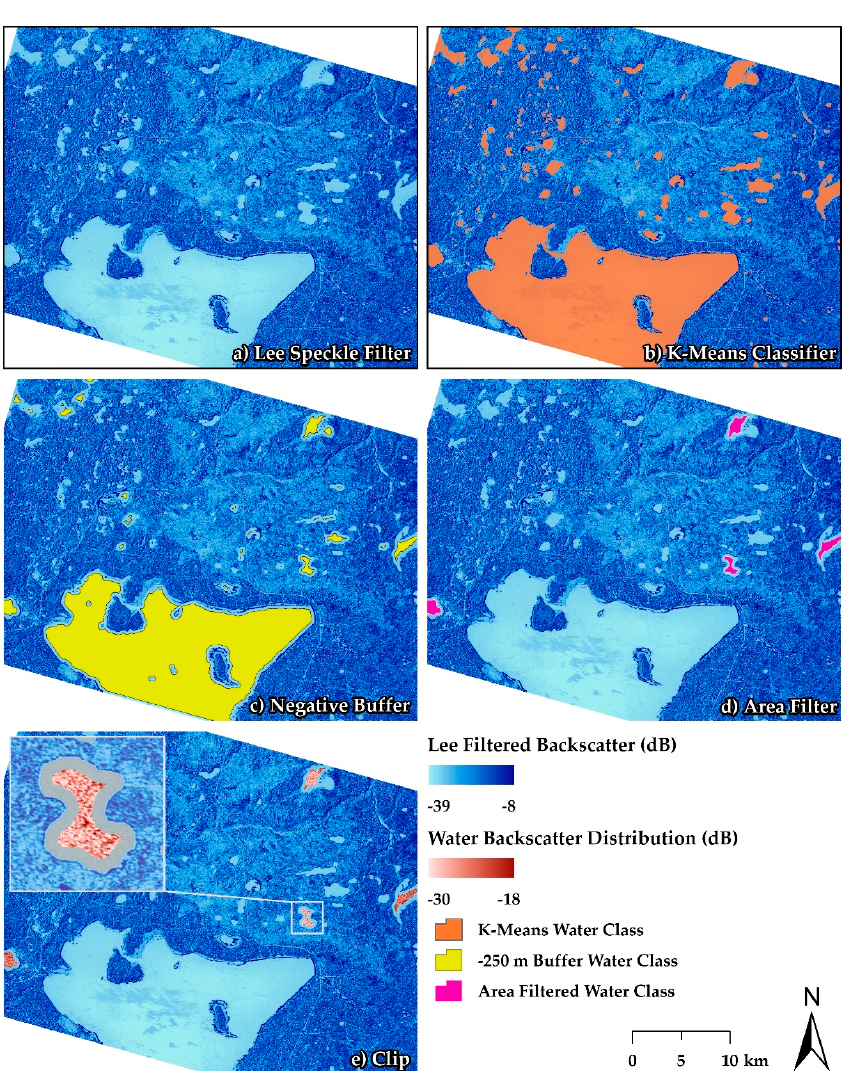
Figure 3. Visualisation of the SAR water mask threshold calibration routine. ( a ) The SAR backscatter image is subject to a Lee speckle filter, followed by ( b ) a 2-class K-Means unsupervised classification. ( c ) A negative buffer ( − 250 m) is applied to remove transitional shoreline influences, ( d ) the resultant polygons from which are filtered by area to remove potential wind and/or aquatic vegetation effects. ( e ) The remaining polygons are used to clip the original SAR backscatter image to yield a surface water backscatter distribution.